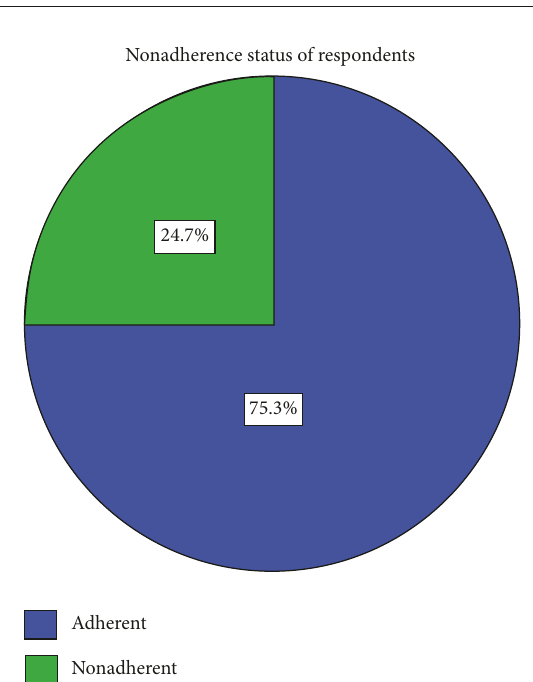
Figure 1: Adherence status of the TB patients that attended TB clinics at governmental health institutions of Arba Minch town, Southern Ethiopia, 2017 (𝑁 = 271) .